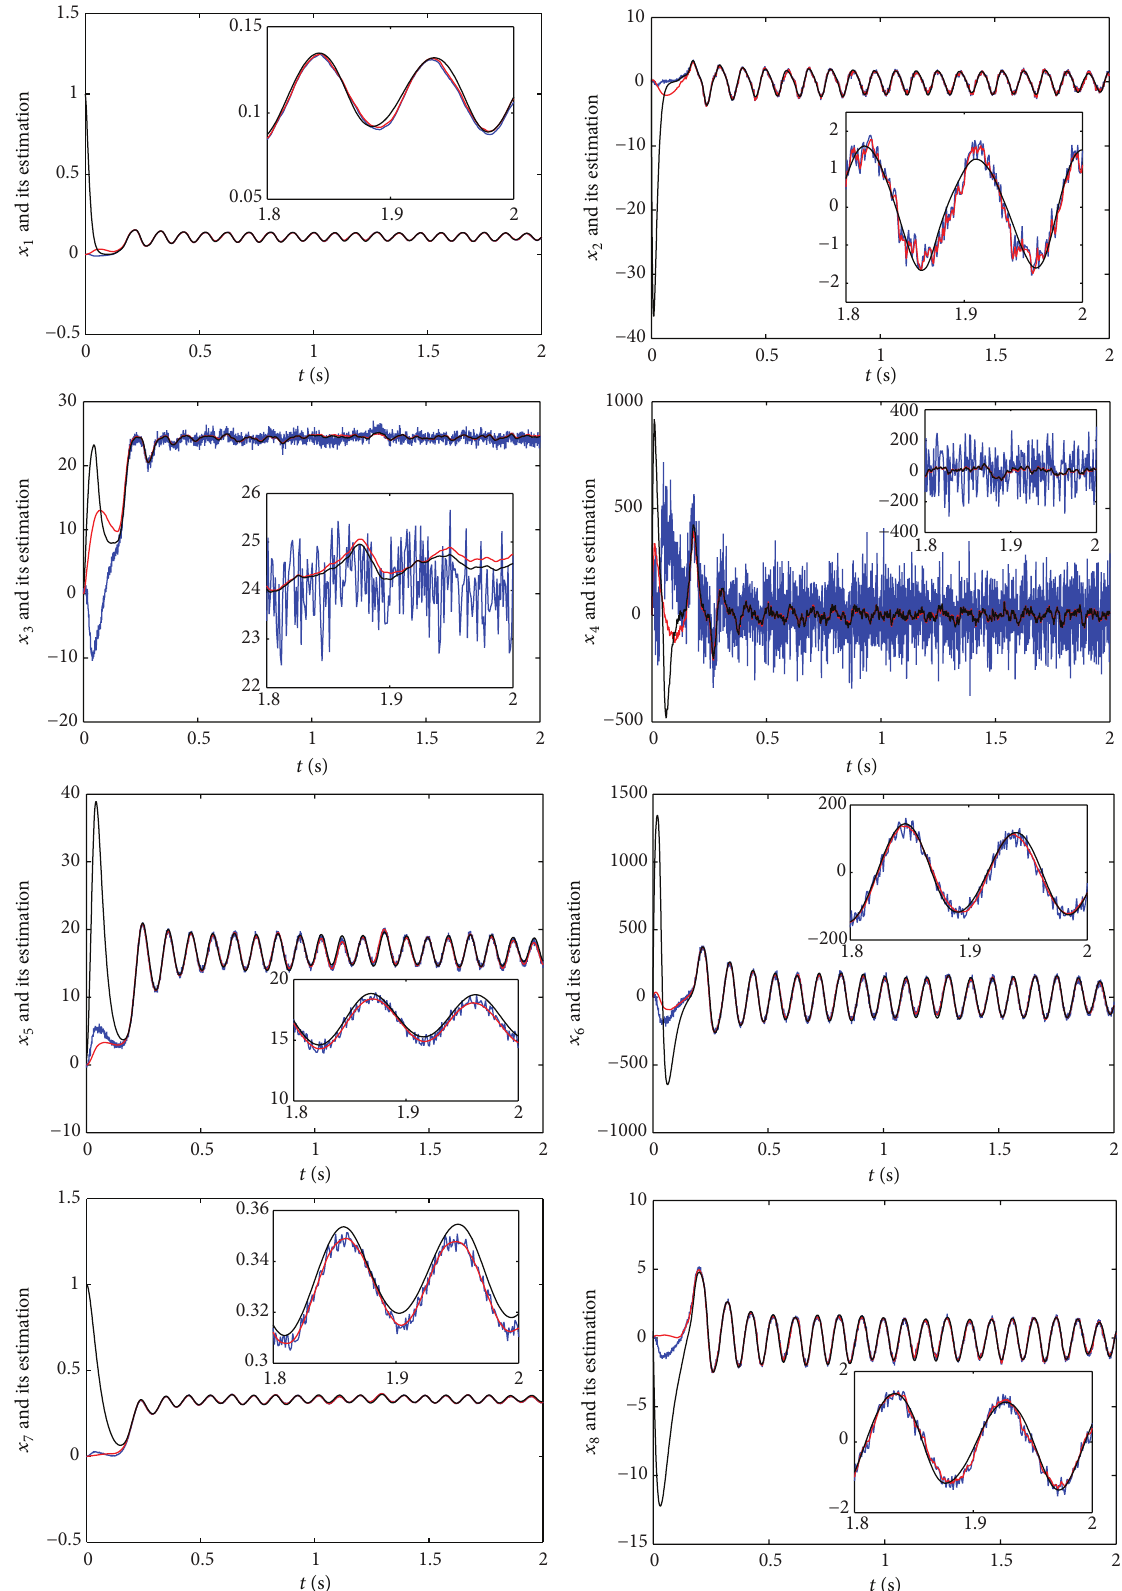
Figure 1: The time evolutions of the states 𝑥 1 – 𝑥 8 and their